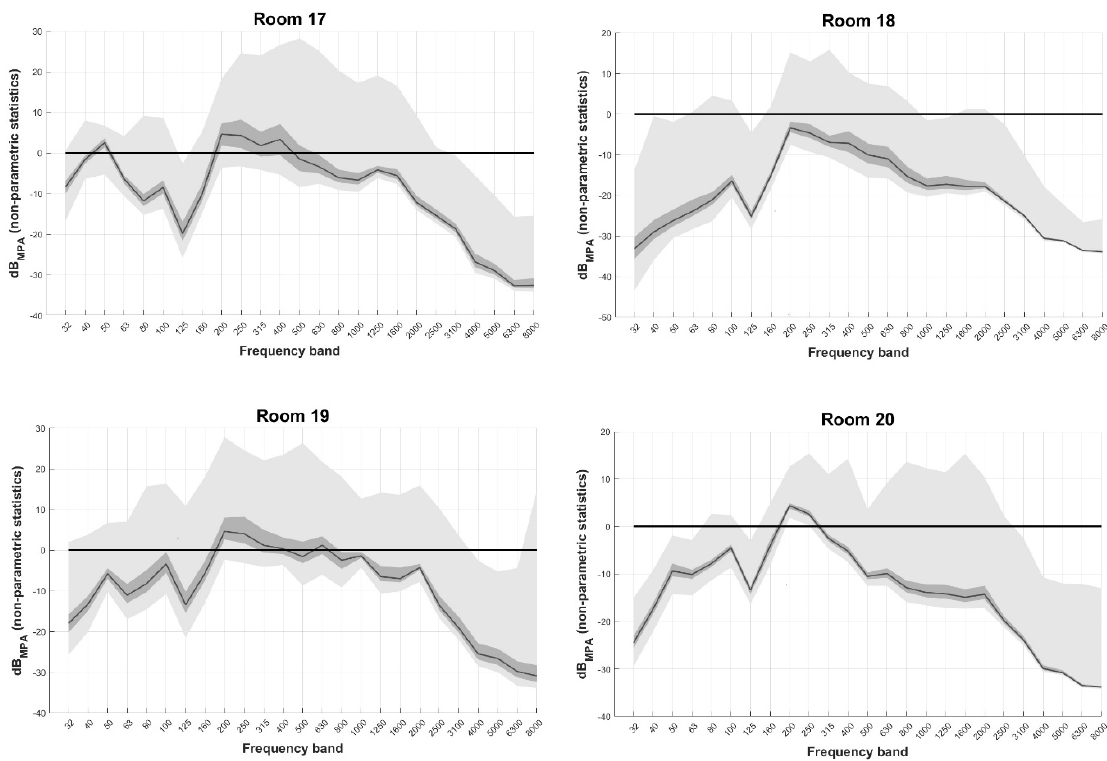
Figure 4. dB MPA non-parametric descriptive statistics per frequency band when supra-aural headphones (DD450) are used for rooms with quasi-constant violations (rooms 17 to 20). Black line: median, dark grey area: 1st to 3rd quartile, light grey areas: min to 1st quartile and 3rd quartile to max. dB MPA refers to levels with respect to Maximum Permissible Ambient noise levels when DD450 circumaural headphones are used.